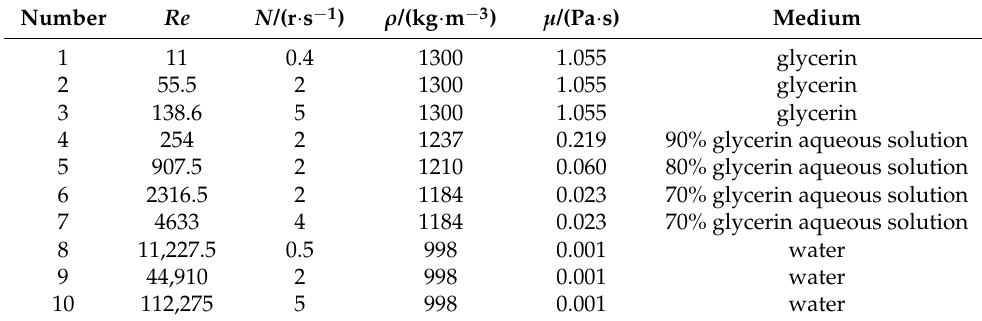
Table 2 lists the ten working conditions adopted in the experiment. Table 2. Torque measurement conditions.